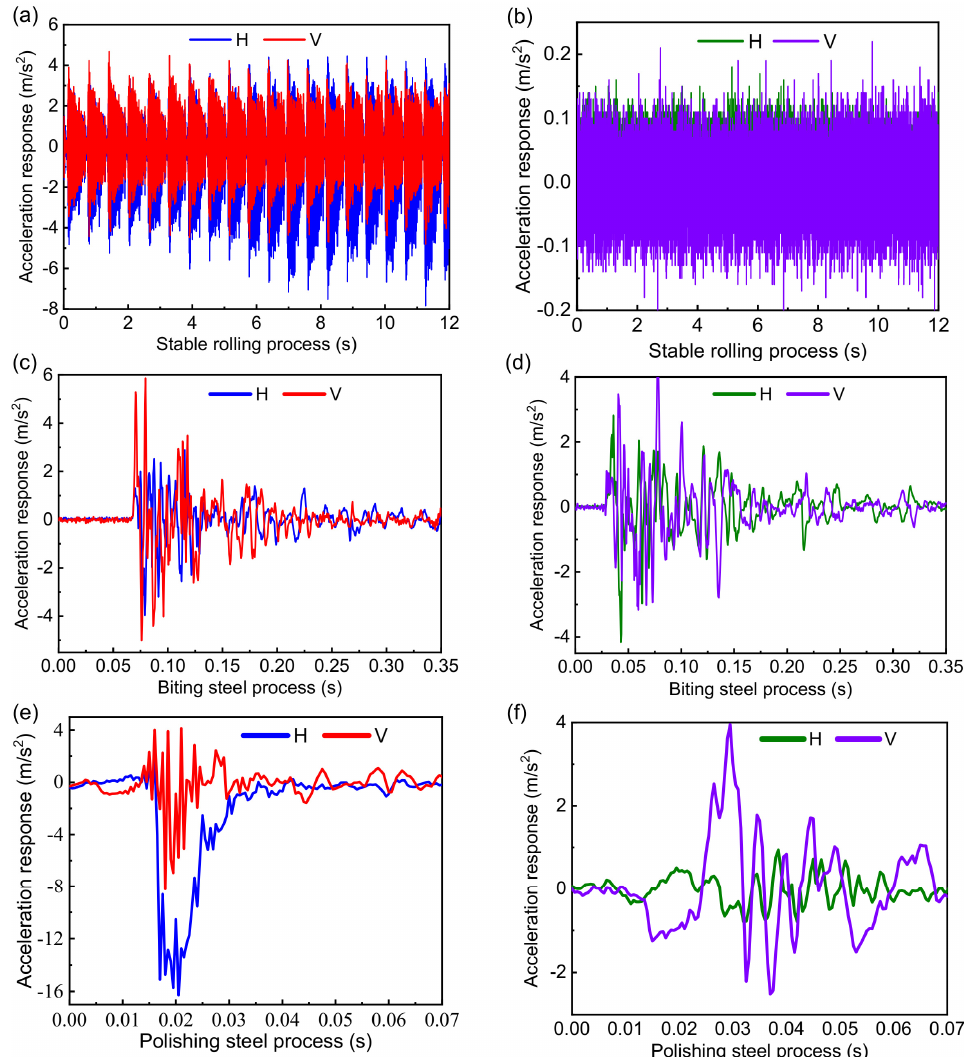
Figure 13. Transient acceleration response of the system when the finished weathering steel thick- nesses are 1.6 and 3.2 mm: ( a ) stable rolling process of the 1.6 mm, ( b ) stable rolling process of the 3.2 mm, ( c ) biting steel process of the 1.6 mm, ( d ) biting steel process of the 3.2 mm, ( e ) polishing steel process of the 1.6 mm, and ( f ) polishing steel process of the 3.2 mm.